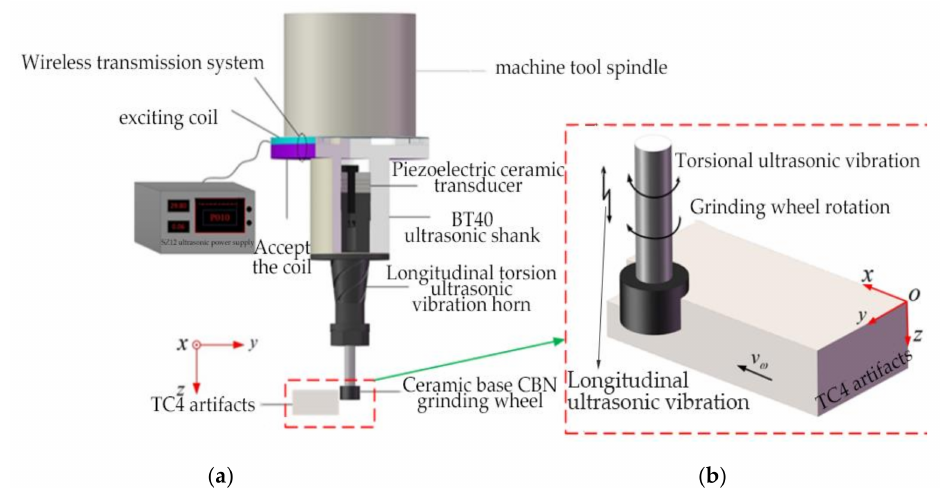
Figure 1. Schematic diagram of the longitudinal-torsional ultrasonic-assisted grinding (LTUAG) system and its motion model. ( a ) Schematic diagram of the grinding system in LTUAG. ( b ) Schematic diagram of the motion model in